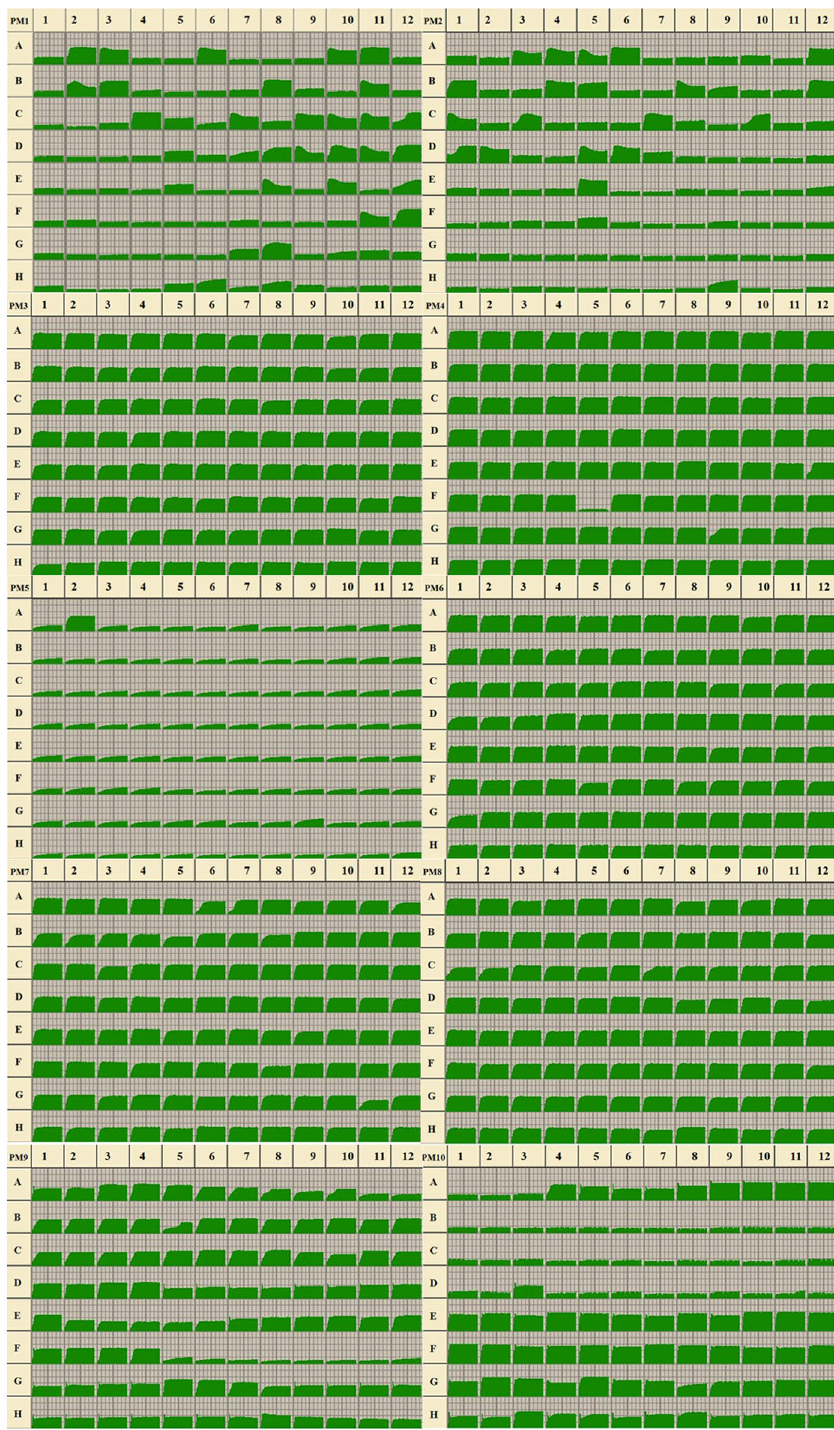
Figure 5. Data for Biolog Phenotype MicroArray PM 1–10 plates of the gut bacteria Enterococcus mundtii NT-1. (Utilization of the isolate of E. mundtii from the DBM gut is indicated by green areas in the growth curve for each substrate. The threshold to consider effective growth of E. mundtii was quantitatively analyzed by Biolog OmniLog software that tested the color value of each